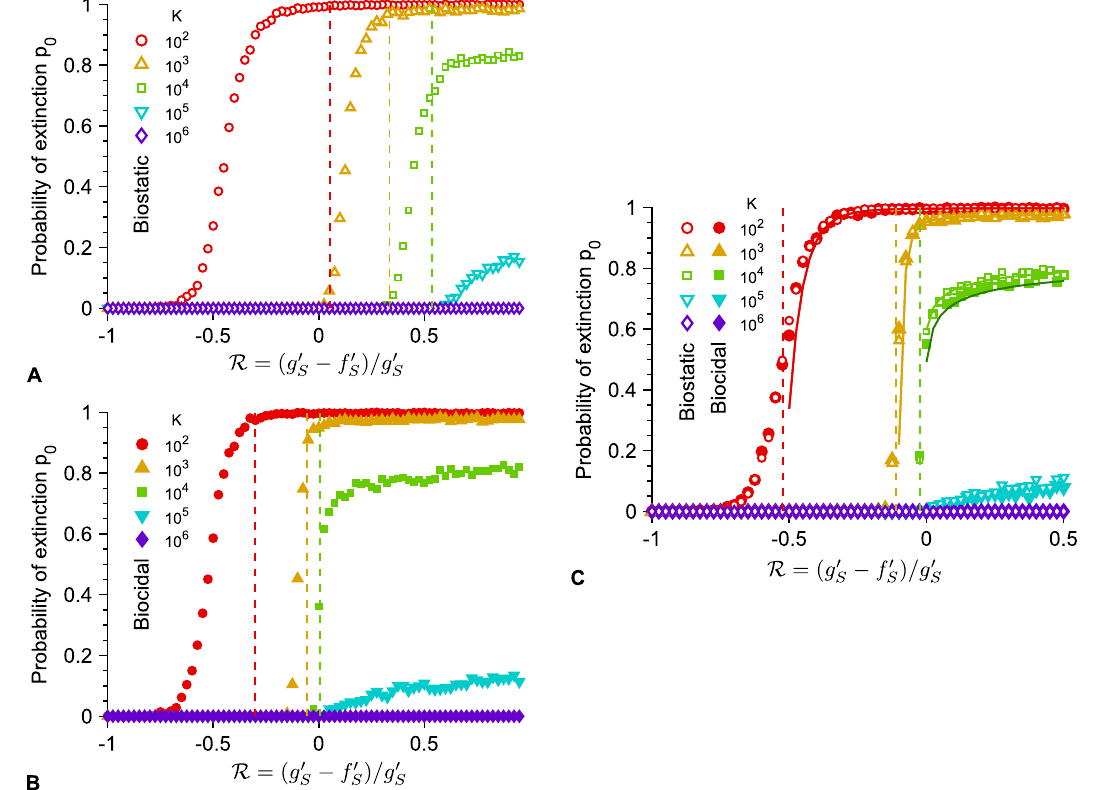
Fig 6. Dependence of the extinction transition on population size and antimicrobial mode of action. Extinction probability p 0 versus the ratio R ¼ ð g 0 (cid:0) f 0 Þ = g 0 with biostatic or biocidal antimicrobial, for different carrying capacities K , either in the small- S S S period regime, with T = 10 2.5 ( A and B ) or in the large-period regime, with T = 10 5 ( C ). Markers: simulation results, calculated over 10 3 realizations. Vertical dashed lines: predicted extinction thresholds, i.e. values of R such that T /2 = τ Solid lines ( C ): Analytical estimates of p 0 from Eq 1 (biostatic) or Eq 4 (biocidal). For K = 10 2 and 10 3 , the analytical predictions in the biostatic and biocidal case are confounded, while for K = 10 4 we used two shades of green to show the slight difference (light: biostatic, dark: biocidal). Parameter values: μ 1 = 10 − 5 , μ 2 = 10 − 3 , f S = 1, f R = 0.9, f C = 1, g S = g R = g C = 0.1, and g 0 ¼ 1 (biocidal). All simulations start with 10 S f 0 S